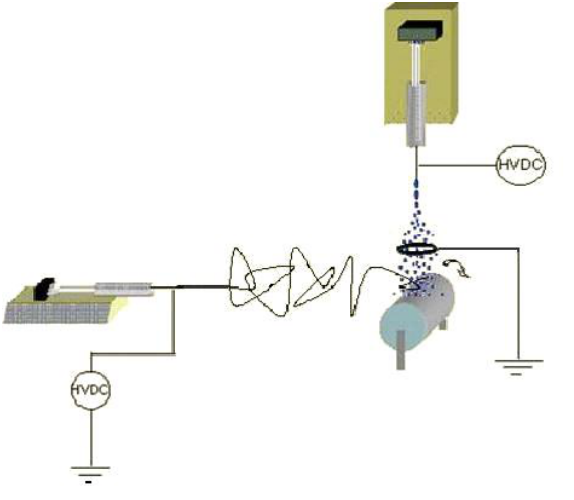
Figure 2. Schematics of the experimental set up used for the combination of electrospinning and electrospraying techniques (Adapted from